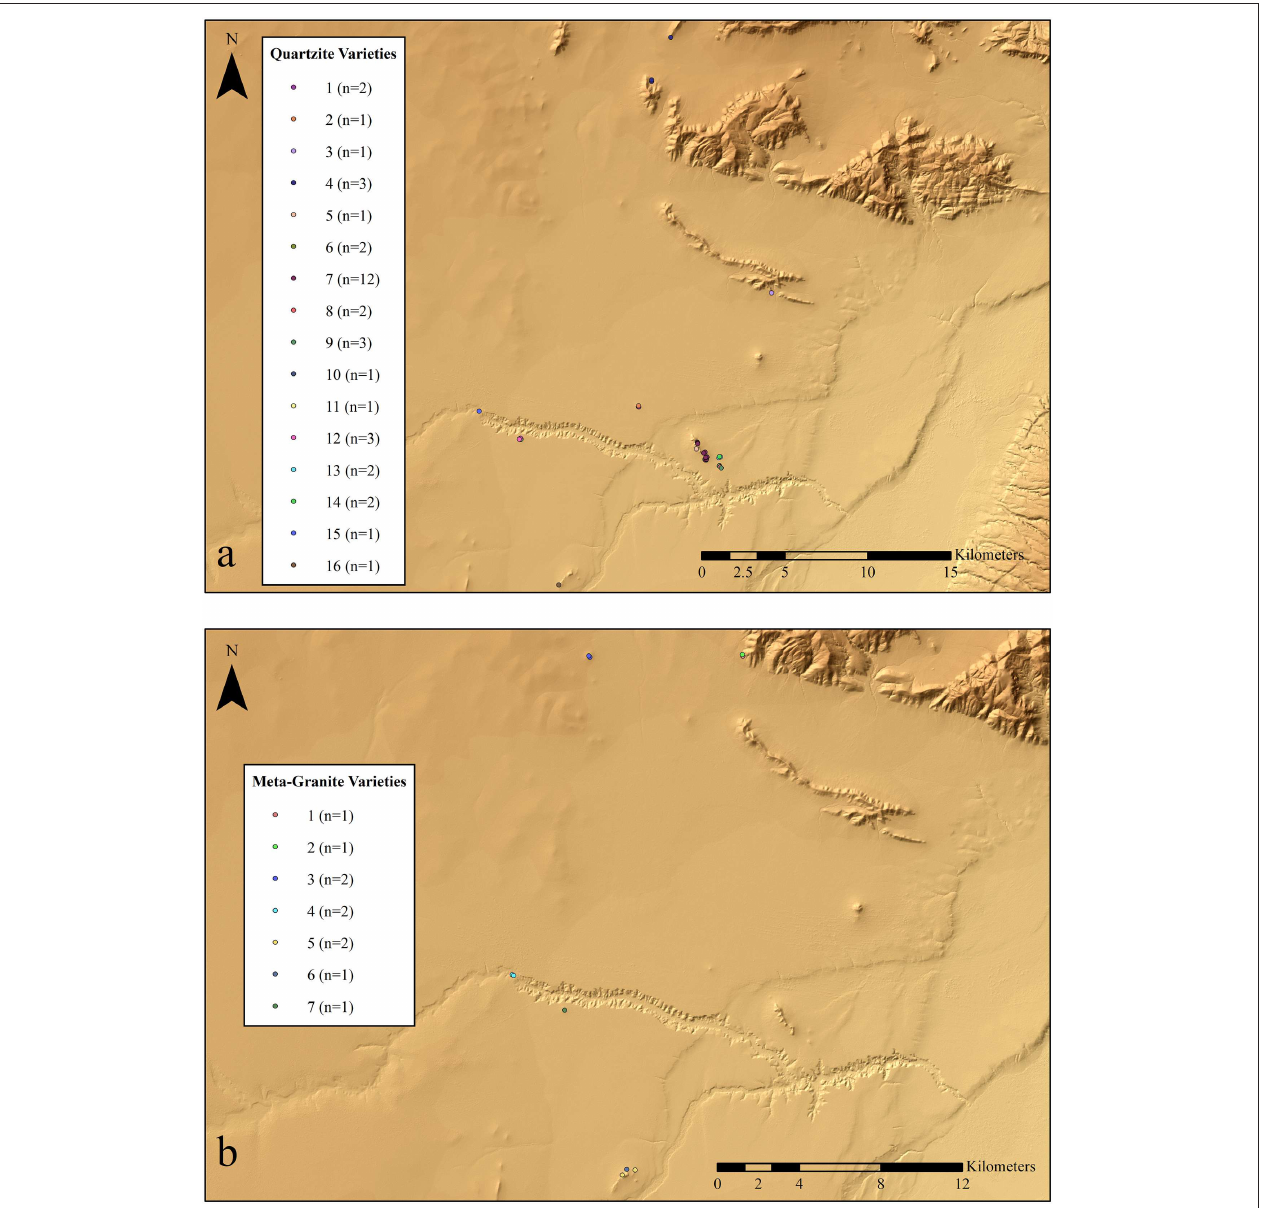
Table 5 for additional